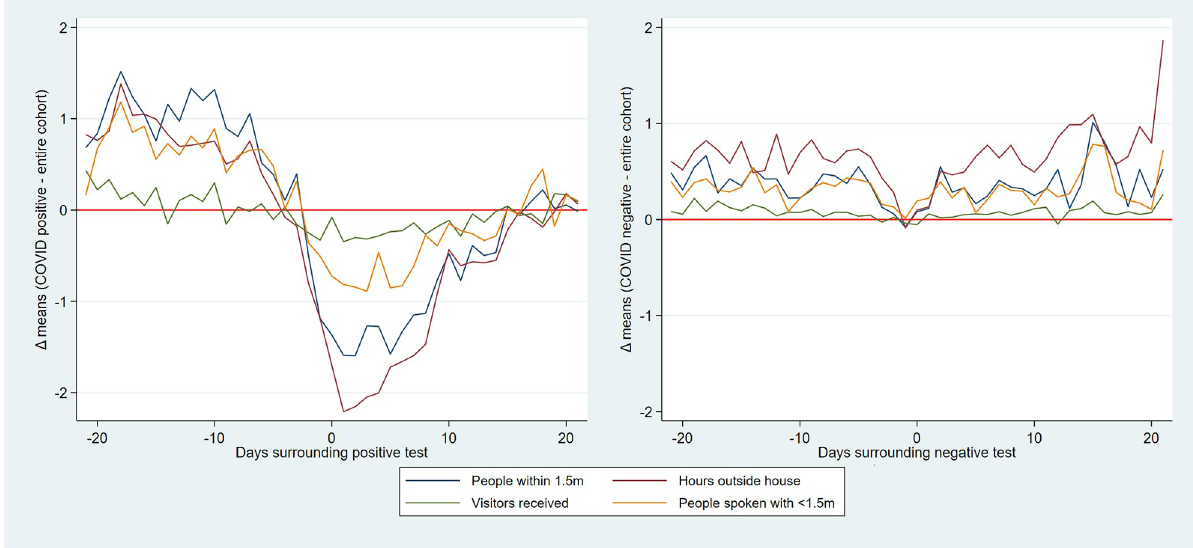
Fig 6. a) Mean difference between SARS-CoV-2 positive users and daily means for behavior variables in the days surrounding positive SARS-CoV-2 test. Red line: no difference. (example: on day 20 before test, on average a positive tested user reported one extra person within 1.5m (blue line) compared with the daily mean). B) Mean differences between SARS-CoV-2 negative users and daily means for behavior variables in te days surrounding negative SARS-CoV-2 test. Data with 95% confidence intervals in